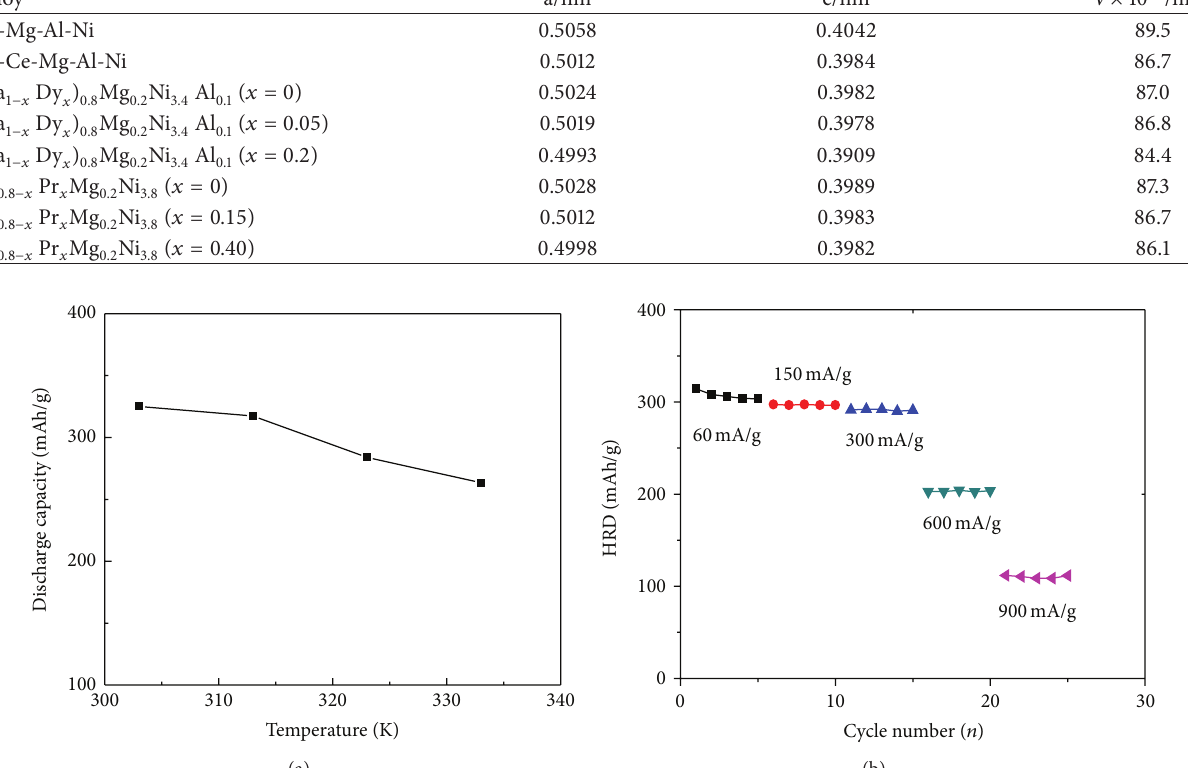
Figure 4: Effect of temperature and discharge current density on the discharge capacity for La 0.96 Ce 0.04 Mg 0.15 Al 0.05 Ni 2.8 alloy.